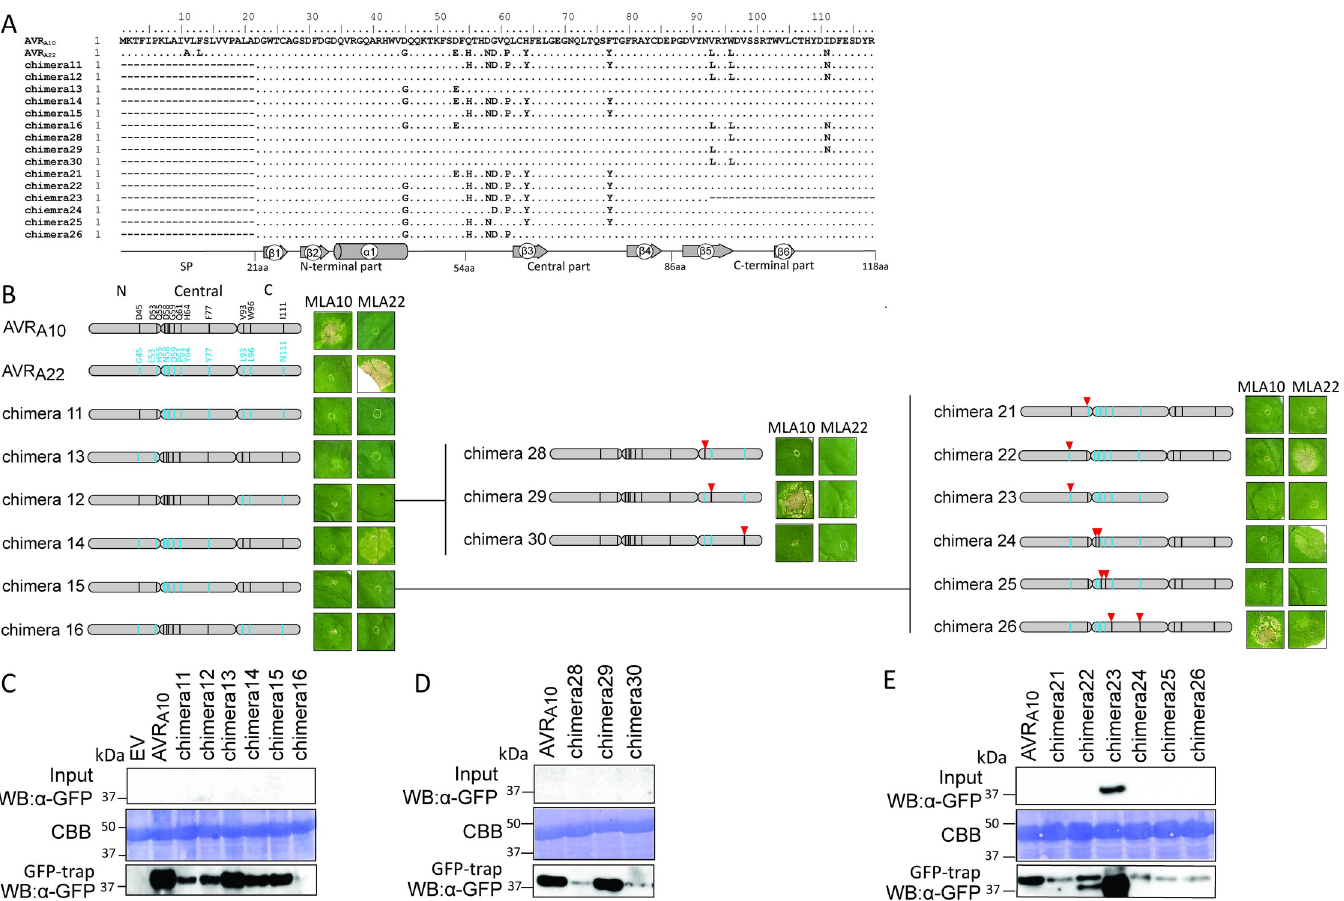
Fig 8. Co-expression of AVR A10 and AVR A22 chimeras with MLA10 and MLA22 in N . benthamiana . (A) Protein sequence alignment of the AVR A10 /AVR A22 chimeric construct. Grey boxes below sequences show the length of the N-terminal, the central and the C-terminal effector part. Dashes represent missing/deletion of effector parts and points designate identical amino acid residues (B) Co-expression of N . benthamiana with cDNAs of AVR a10 , AVR a22 , or chimeric AVR a10 /AVR a22 constructs fused C-terminally with mYFP and Mla10 or Mla22 cDNAs fused C-terminally with a 4xmyc tag from the 35S promotor in N . benthamiana leaves. Cell death was scored five days post infiltration and Figures show a representative of at least seven co-transformations. (C-E) Protein levels of AVR A -mYFP and chimeric AVR A10 / AVR A22 mYFP variants after total protein extraction from N . benthamiana leaves at two dpi. Proteins were separated on a 12% polyacrylamide gel and detected by α - mYFP western blotting.